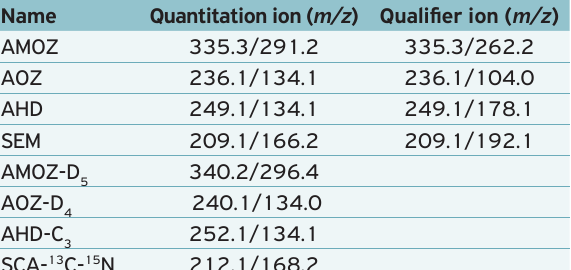
Table 2. Multiple reaction monitoring set for metabolites of nitrofurans.